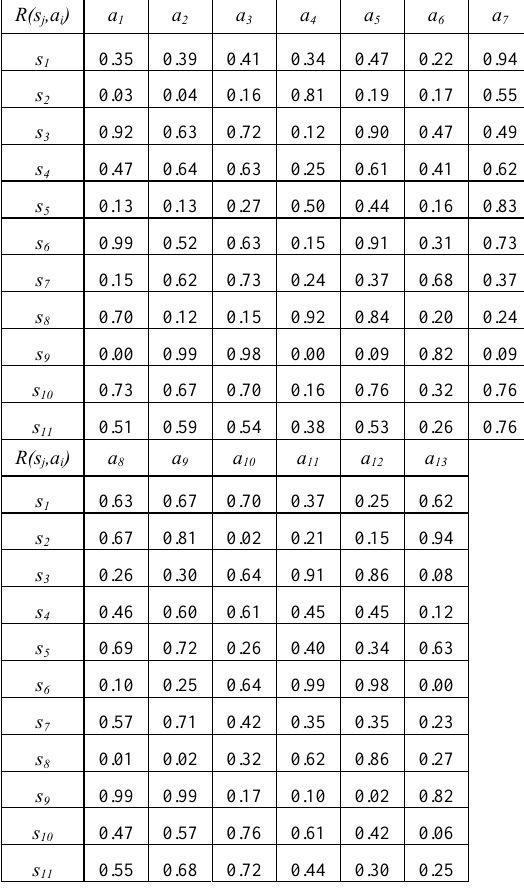
Table 4. Similarity value between a j and s